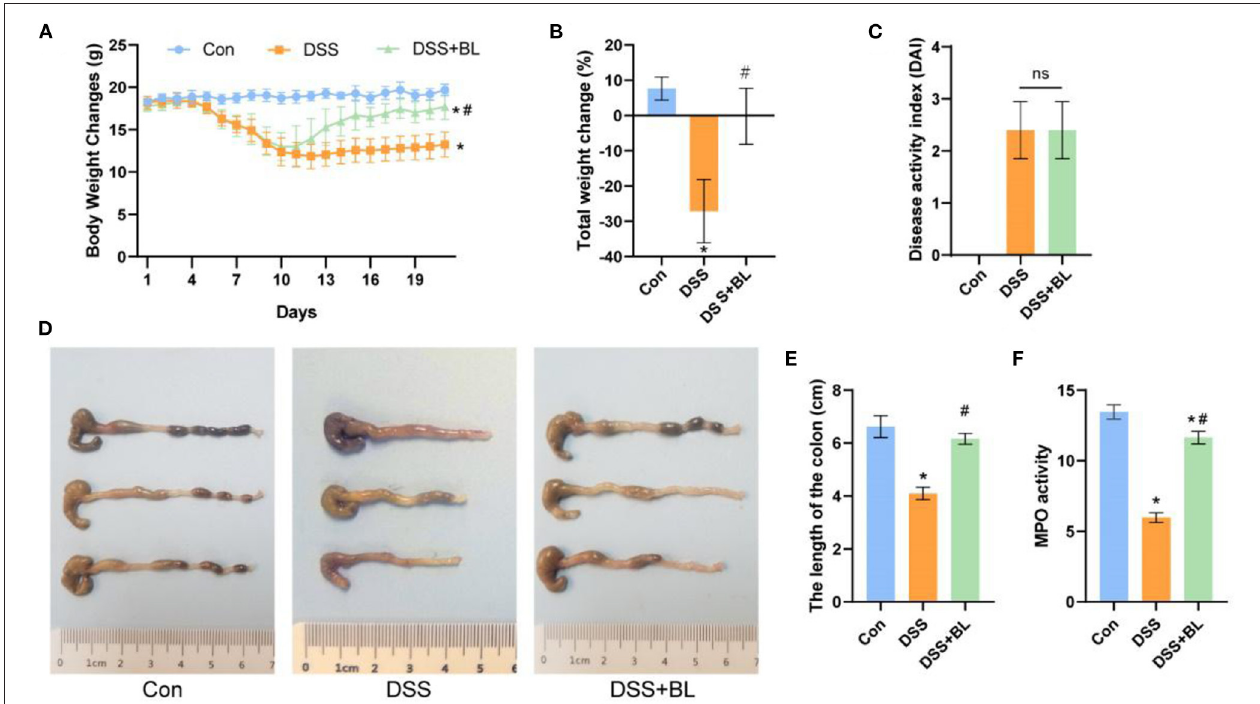
FIGURE 1 | Effects of bovine lactoferrin (BL) on changes in body weight, colon morphology, and myeloperoxidase (MPO) activity in dextran sulfate sodium salt (DSS) mice. (A) Changes of body weight of mice in each group within 19 days since start of modeling. (B) Changes of the rate of total weight of mice in each group within 19 days. (C) Changes of disease activity index (DAI) index on the seventh day after modeling. (D) Pictures of colons in each group. (E) Changes of colon length of mice in each group. (F) Changes of MPO activity in colon of mice in each group. One-way ANOVA was used to compare the three groups. * P < 0.05 vs. control; # P < 0.05 vs. DSS. n =